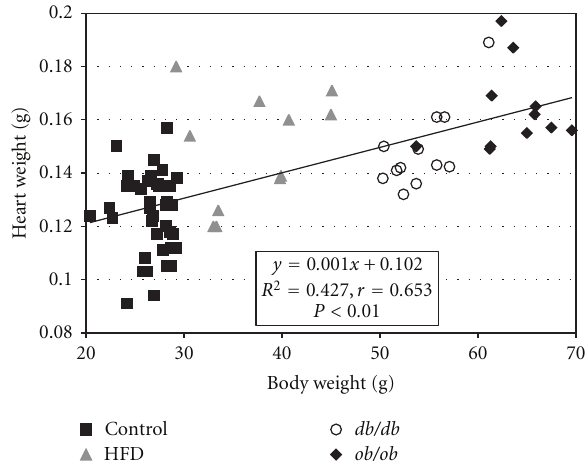
Figure 1: Heart weights were significantly correlated with body weight across the four experimental groups ( P < 0 .